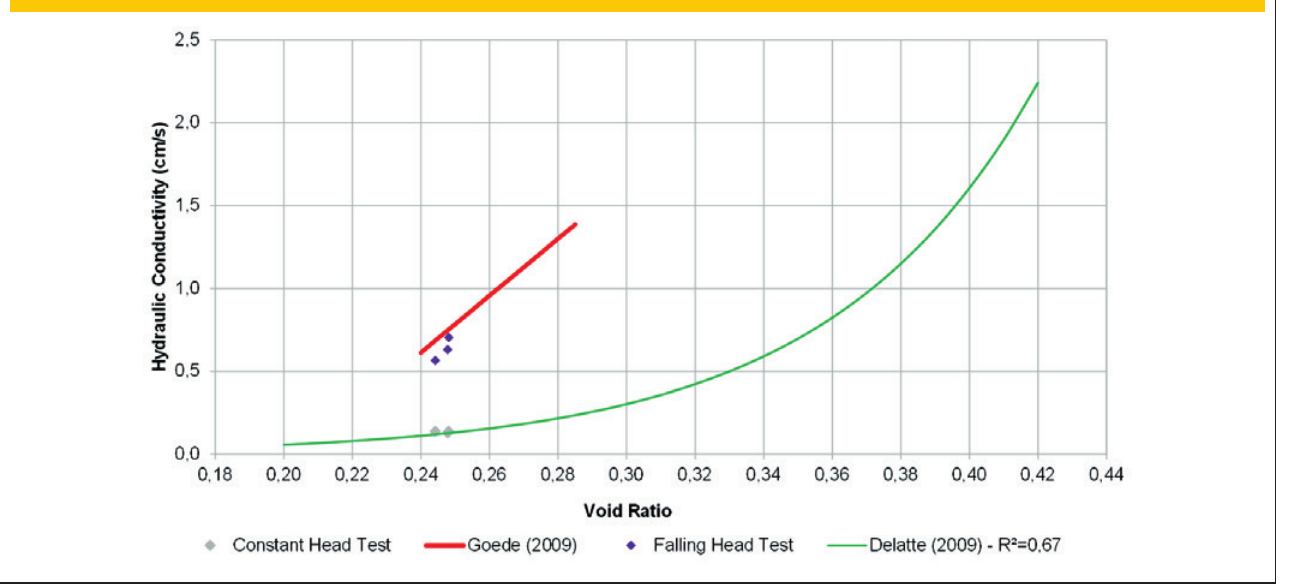
Figure 5 – Hydraulic conductivity variation obtained by the two methods versus void ratio